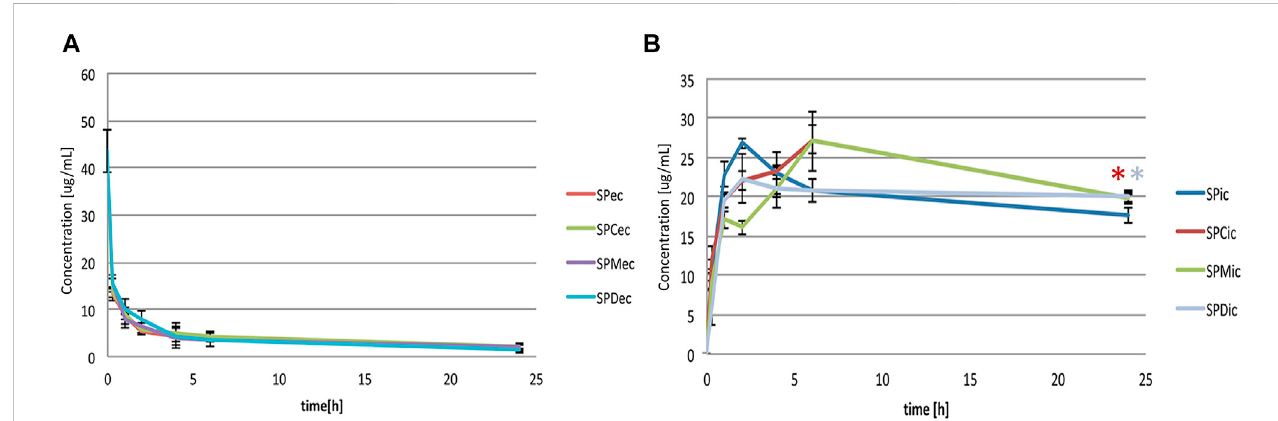
FIGURE 2 (A) Effect of bile acids on extracellular simvastatin concentration over the 24-h incubation (SP ec - simvastatin with probiotics; SPC ec , SPM ec , SPD ec - simvastatinwithprobioticsandadditionofCA,12-MKC,DCA,respectively) (B) Effectofbileacidsonbioaccumulationofsimvastatinbyprobioticbacteriaover the 24-h incubation (SP ic - simvastatin with probiotics; SPC ic , SPM ic , SPD ic - simvastatin with probiotics and addition of CA, 12-MKC, DCA, respectively). Bile acidsdidnotleadtoasigni fi cantchangeintheconcentrationsofsimvastatininextracellularmediumduringthe24-hincubation.Duringthe fi rst4 hours ofincubationwithprobioticbacteria,statisticallylowerintracellularconcentrationswereobservedingroupswithbileacidscomparedtothecontrolgroup.At the end of incubation higher levels of simvastatin in groups with bile acids were recorded (in groups with CA and DCA with statistically signi fi cant difference compared to the control, * p < 0.05) with no signi fi cant differences between bile acids